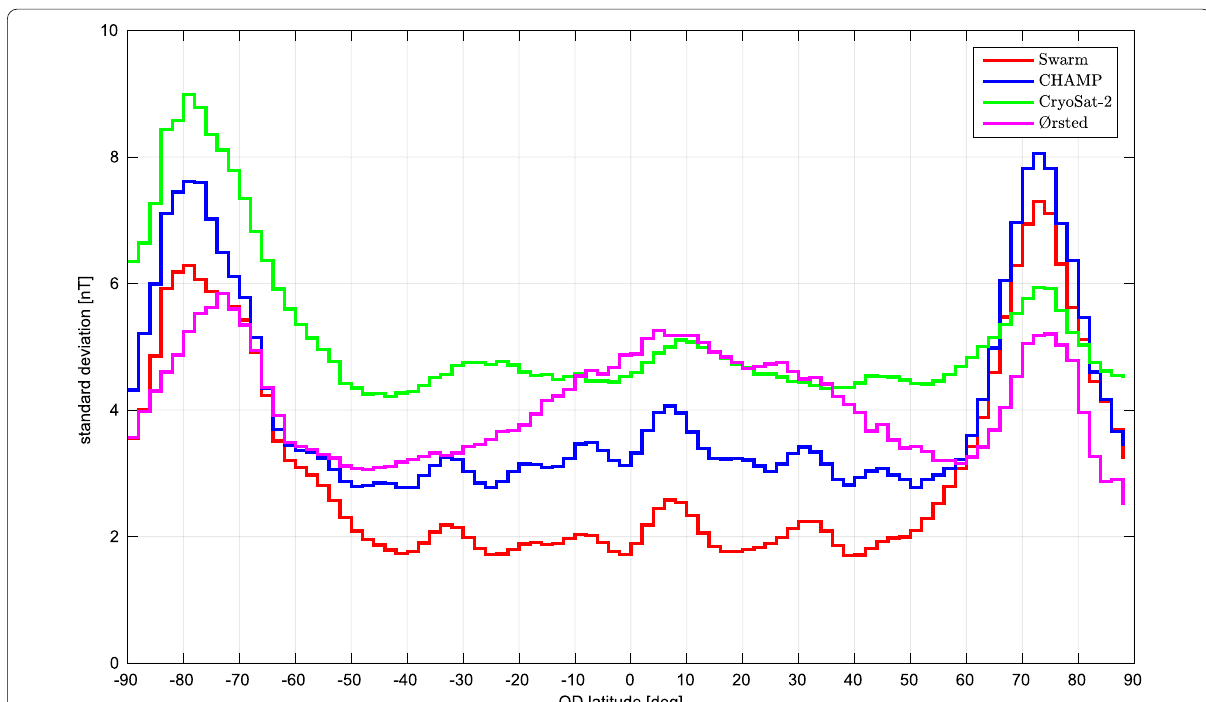
Fig. 6 Latitude-dependent standard deviations, σ(θ QD ) , contributing to the data error budget. For the radial field component in 2 ◦ bins (Northern hemisphere having positive QD latitude) for each satellite